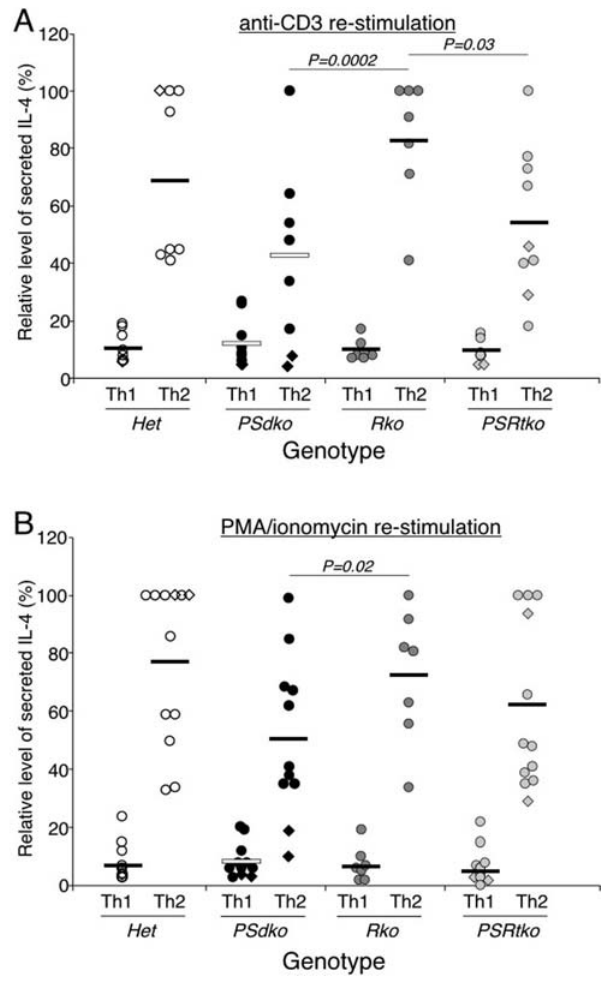
Figure 6. Reduced level of IL-4 secretion from PS1/PS2 and not RBP-J deficient Th2 cells. (A, B) PS1/PS2-deficient T cells have significant reduction in IL-4 cytokine production when compared to RBP-J-deficient T cells independent of the mode of re-stimulation. The experiments were conducted as described in Figures 5. Data is presented as the relative level of IL-4, determined by comparing the IL-4 secretion from individual mouse over the maximum level attained in each separate experiment. The P value was determined by two-tailed paired t test. doi:10.1371/journal.pone.0002823.g006 DO11.10 CD4 + T exposed to three different concentrations of OVA peptide (Figure 1C). These results indicated that activation